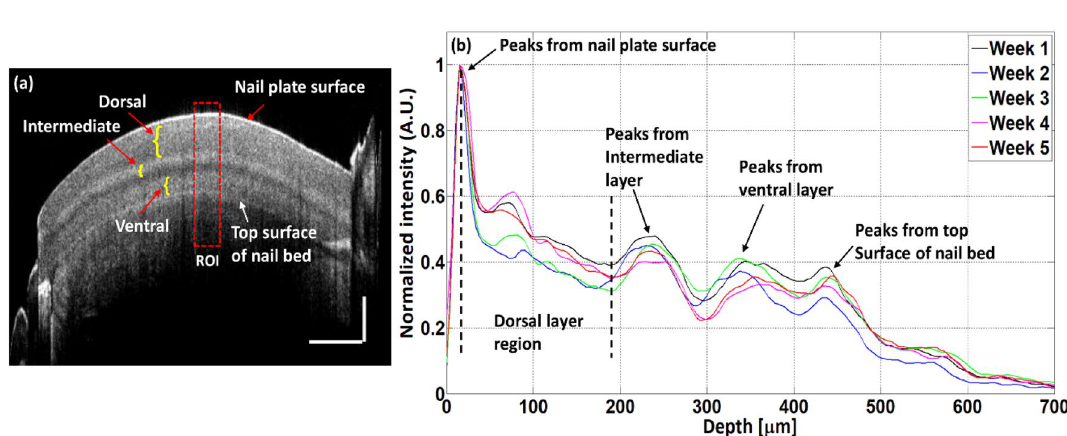
Figure 9. Nail plate thickness measurement process of control and art-removed nails. Image ( a ) 2D cross- sectional OCT image. Image ( b ) depth profiles of a nail in consecutive five weeks of